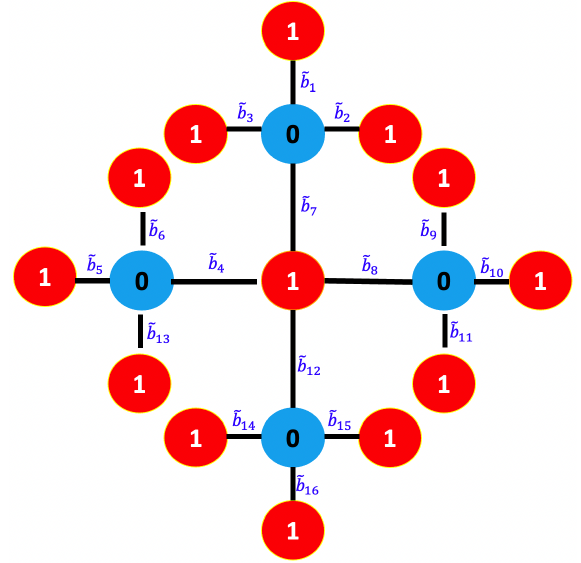
Figure 4. Neopentane compound graph with vertices 0 or